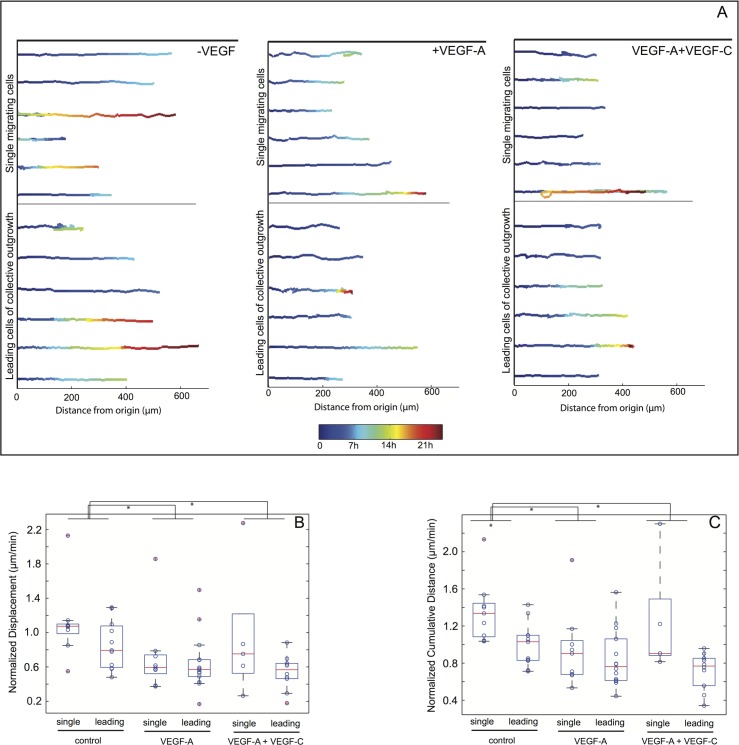
Leading cells of collective HUVEC outgrowth events exhibit higher motion persistence.HUVEC coated beads were incubated with Fn fibers for 6h and then observed with phase contrast video-lapse microscopy. (A) Representative trajectories of cells migrating along Fn fibers, either as single cells (upper panel) or as leading cells of collective outgrowth events (lower panel), in the absence (left) or presence of 50 ng/ml VEGF-A (middle) or 50 ng/ml VEGF-A plus 200 ng/ml VEGF-C (right). The cell tracks shown have been normalized with respect to their origin, as well as the fiber angle. The color denotes time, from the beginning of the track (blue) until 24h (red). From all the cell trajectories analyzed, normalized displacements (B) and cumulative distances (C) travelled by the cells are plotted as box plots, where the central mark is the median (16 to 50 beads per conditions were analyzed), the edges of the box are the 25th and 75th percentiles, the whiskers extend to the most extreme data points not considering outliers (red crosses). The circles superimposed with the box plots show the raw data. Statistical significance was tested with a linear regression model (S7 and S8 Fig). * p-value < 0.001.